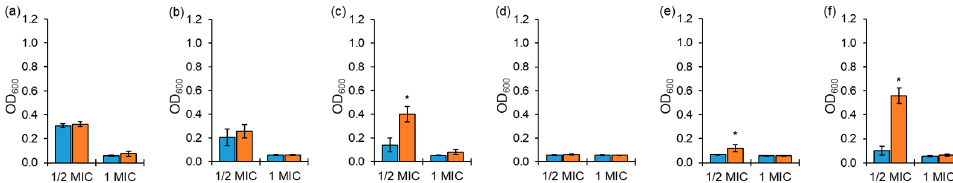
Figure 2. Growths of antibiotic-resistant Salmonella Typhimurium CCARM 8009 (ARST) exposed to ½ and 1 MICs of chloramphenicol ( a ), erythromycin ( b ), tetracycline ( c ), cephalothin ( d ), ciprofloxacin ( e ), tobramycin ( f ) at 0 h ( ■ ) and 10 h ( ■ ) delayed inoculation. * indicates the significant difference within MIC at p < 0.05.